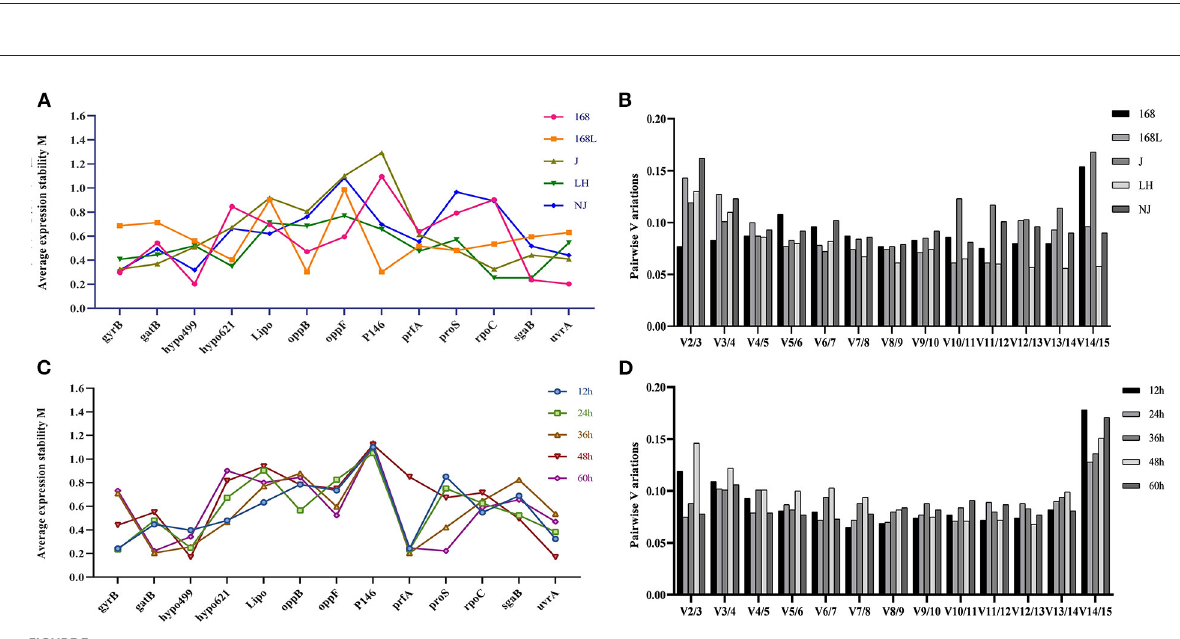
FIGURE3 Average expression stability M-value and optimal number of reference genes according to geNorm analysis. The expression stability of 13 candidate genes in the same strain at different culture time (A) and different strains at the same culture time (C) was calculated. The x-axis represents various candidate reference genes. The y-axis represents stability value (M-value). Lower M-value suggests higher expression stability. (B) and (D) show the optimal number of reference genes in different subsets. The x-axis represents the number of genes selected for comprehensive analysis V (n/n + 1), and the y-axis means the pairwise variation value (V-value). When the V-value is < 0.15, the corresponding combination is deemed stable; n is the best number of internal reference